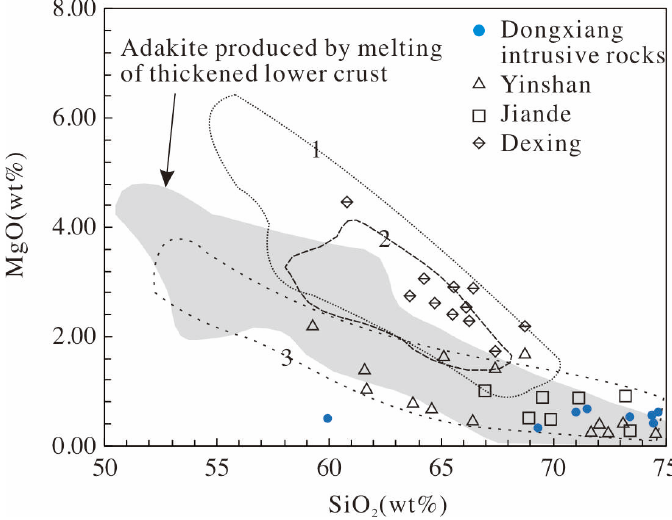
Figure 10. MgO vs. SiO 2 diagram for the Dongxiang intrusive rocks, showing (1) adakite that is produced by melting of subducted oceanic slab; (2) Delaminated lower crust-derived adakitic rocks; (3) metabasaltic and eclogitic melts (1.0–4.0 GPa) [55]. Data were obtained from Zhao and Zhou, 2008.